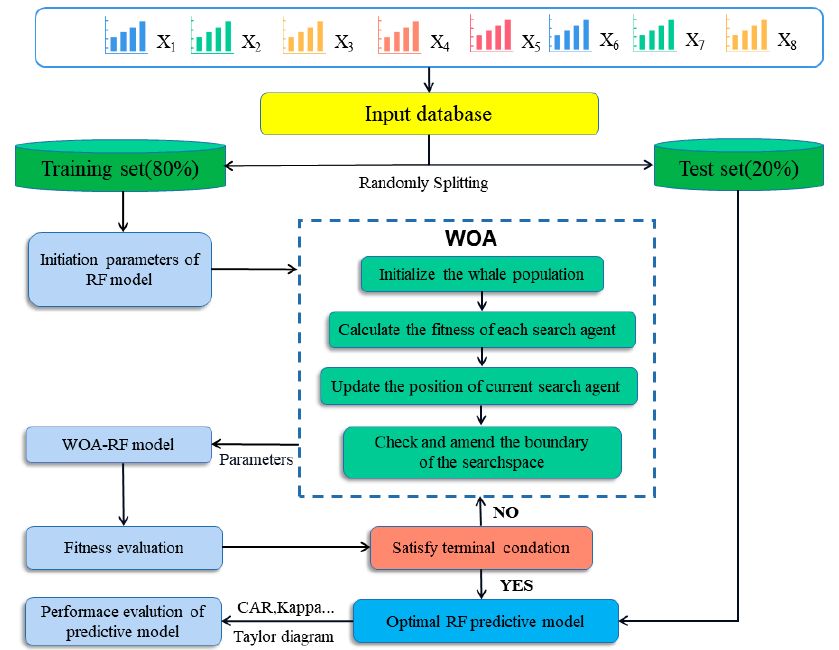
Figure 5. The whole analysis process of the WOA–RF hybrid classifier